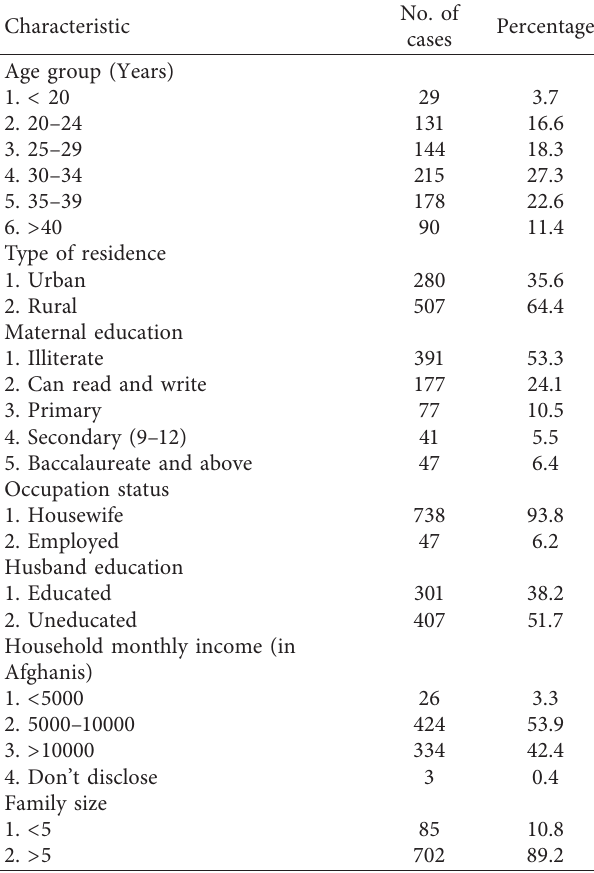
Table 1: Socioeconomic and demographic characteristics of the pregnant women visiting Bost Hospital for delivery in Helmand province, 2019 ( n � 787).